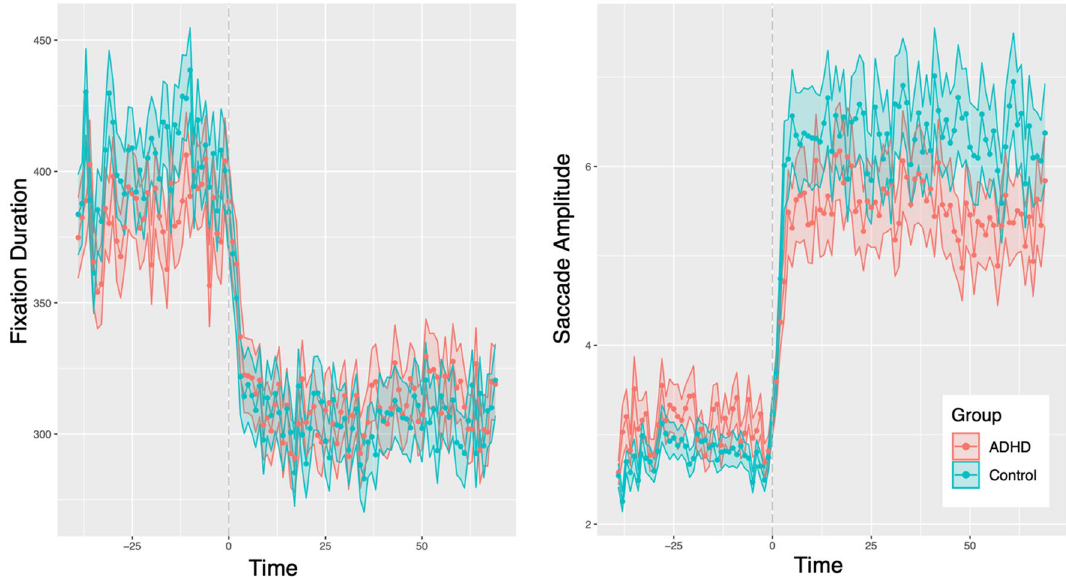
Figure 5. Eye movement characteristics over time. Zero time point indicates when instruction phase ended, and task execution phase started. ( A ) Fixation Duration, ( B ) Saccade Amplitude; for all features tested in the analysis see Fig. S1 in Supplementary Results: Ambient versus Focal